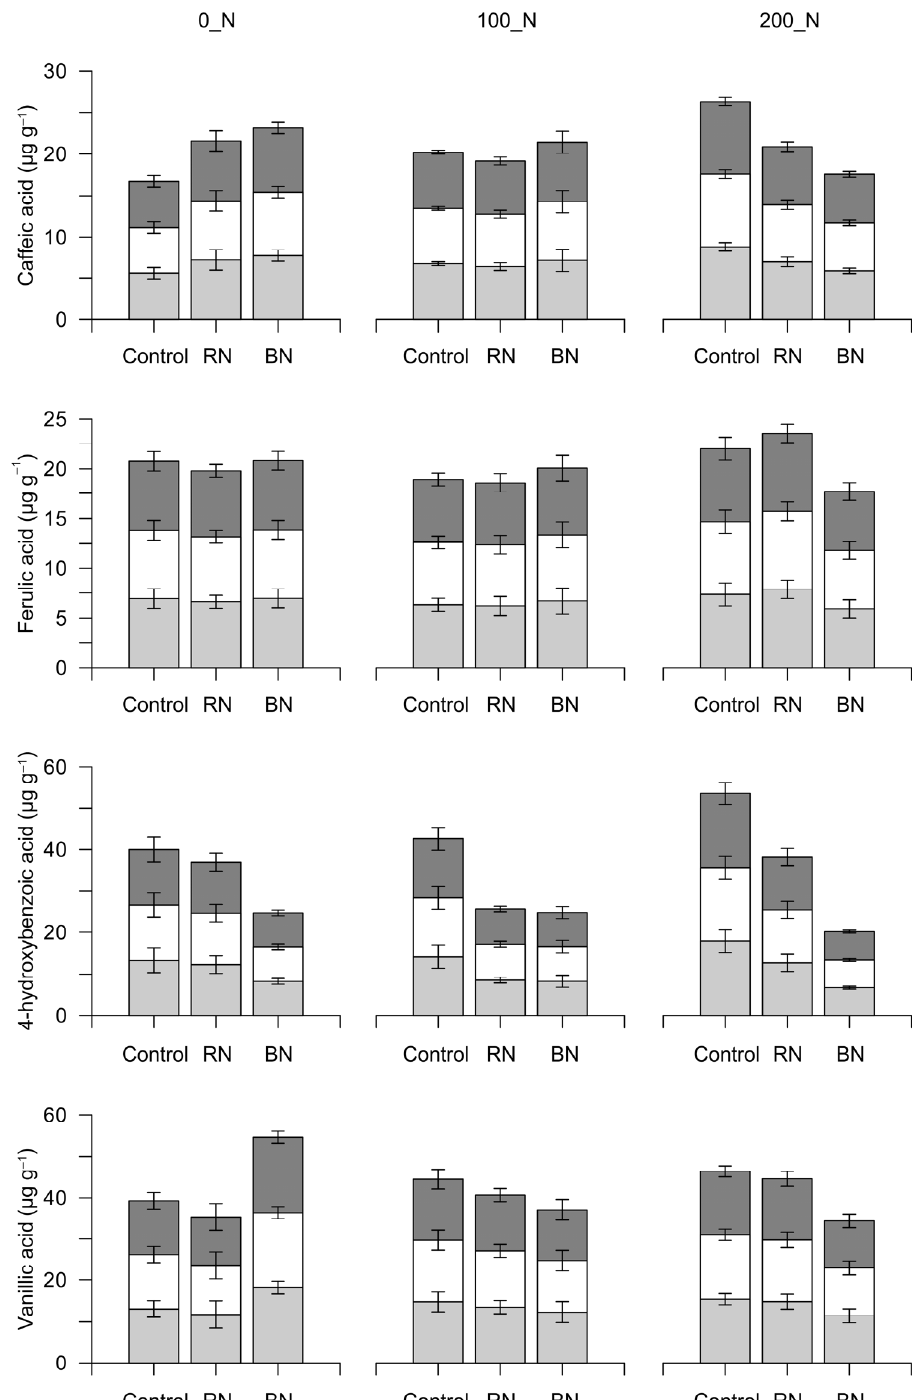
Figure 3. Phenolic acid content ( µ g g − 1 dry weight), as determined in pepper fruits from plants subjected to different N fertilization rates (first column, 0_N: 0 kg N ha − 1 ; second column, 100_N: 100 kg N ha − 1 ; third column, 200_N: 200 kg N ha − 1 ) and shade levels (accomplished using: no cover, Control; red photoselective net, RN; black photoselective net, BN) at harvest (83 days after transplanting, DAT), in 2017. Light gray chart: green fruits, G_fru; white chart: early-ripening fruits, RI_fru; deep gray chart: red fruits, R_fru. Data are means ± standard errors, over Exp_1 and Exp_2 ( n =